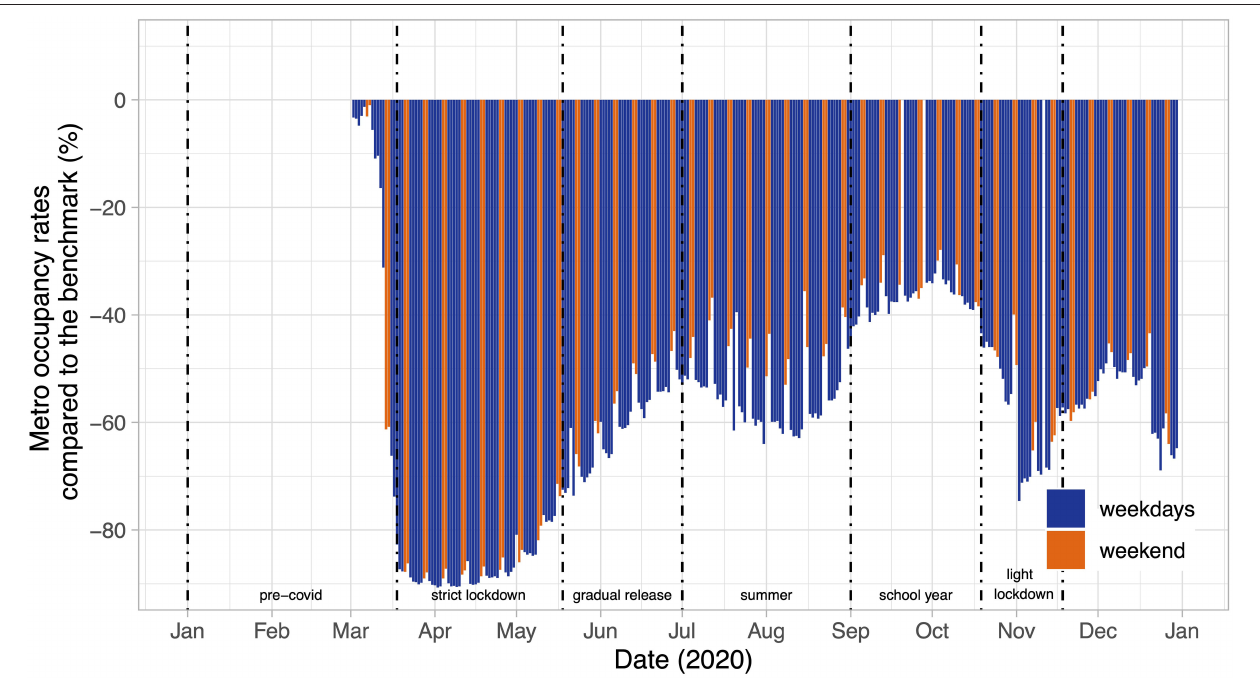
FIGURE 5 | Evolution of the city public transport occupancy rates (metros) compared to their pre-lockdown benchmark (source: STIB-MIVB). Days with unusual values justified by special events were retrieved, by the operator, from the dataset.